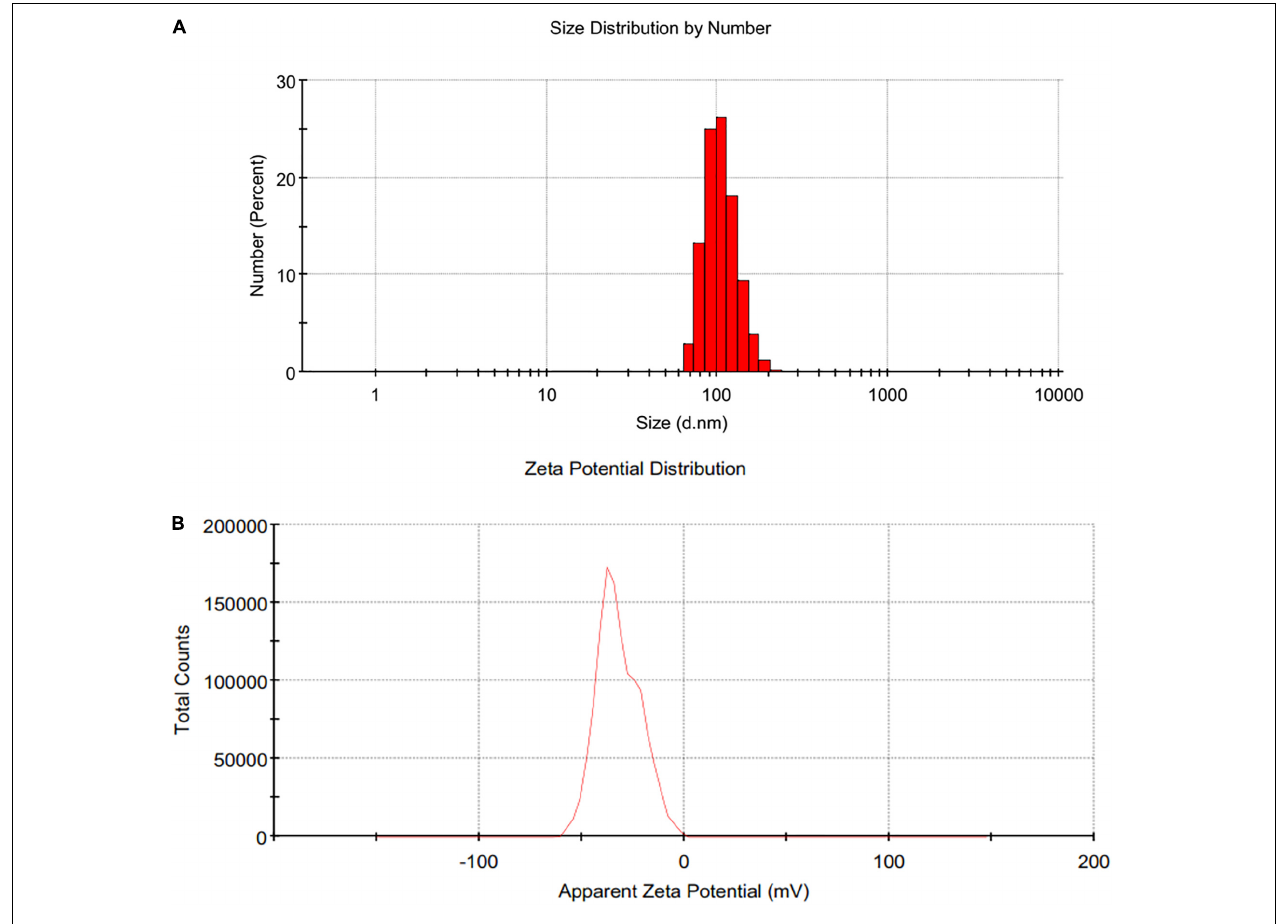
FIGURE 4 | (A) DLS and (B) Zeta potential of